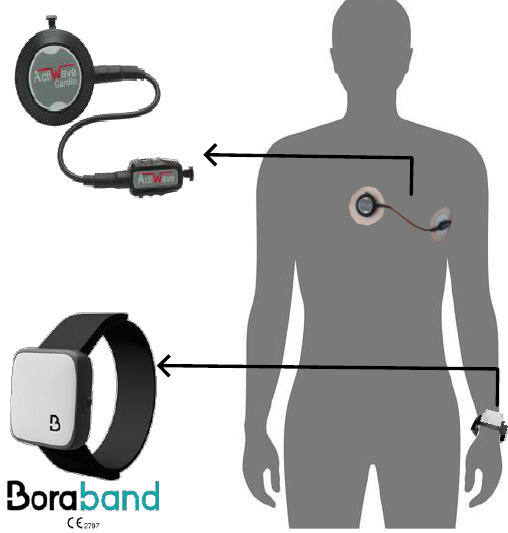
Figure 1. Actiwave and Bora Band placements during acquisitions.